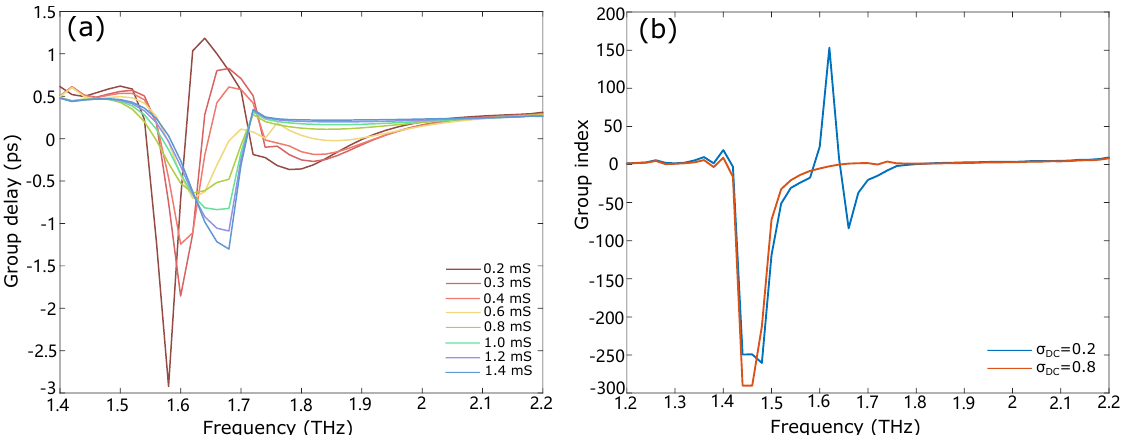
Figure 4. ( a ) Group delay of the metal–graphene device at different DC graphene conductivities. The maximum positive group delay is 1.2 ps at 1.64 THz when σ DC = 0.2 mS. The group delay is reduced with the increase in the graphene conductivity. ( b ) The group index plot at two different graphene conductivities. When σ DC = 0.2 mS, the value of n g is larger than 150 within the EIT transparency window, while n g is near 0 when σ DC = 0.8